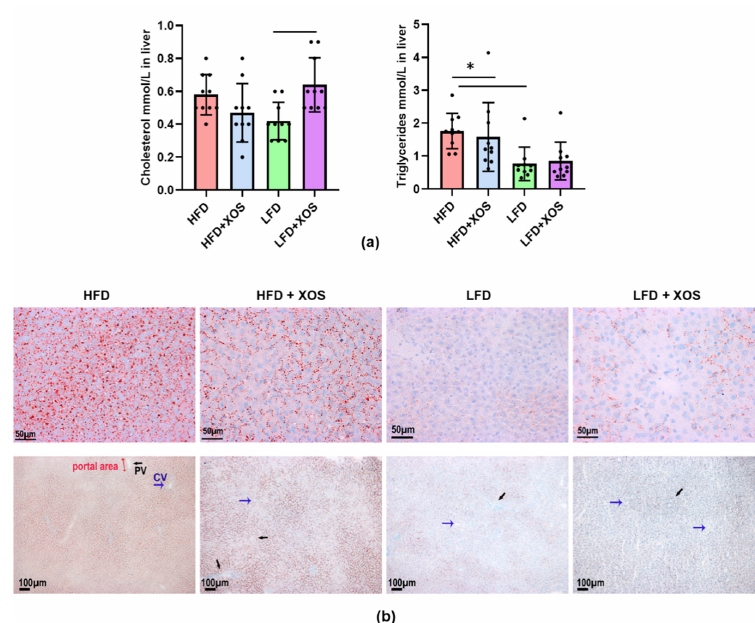
data points are shown with black dots. HFD = high-fat diet. LFD = low-fat diet. * indicates statistically